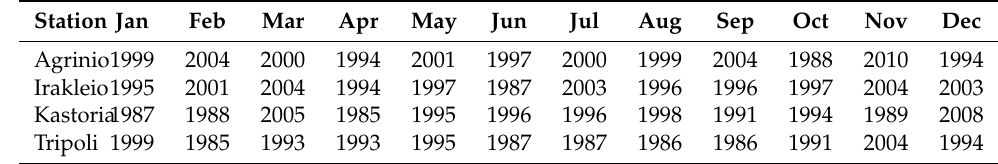
Table 3. The HNMS stations of Agrinio, Irakleio, Kastoria, and Tripoli with their typical meteorologi- cal months (TMMs) selected from years within the period